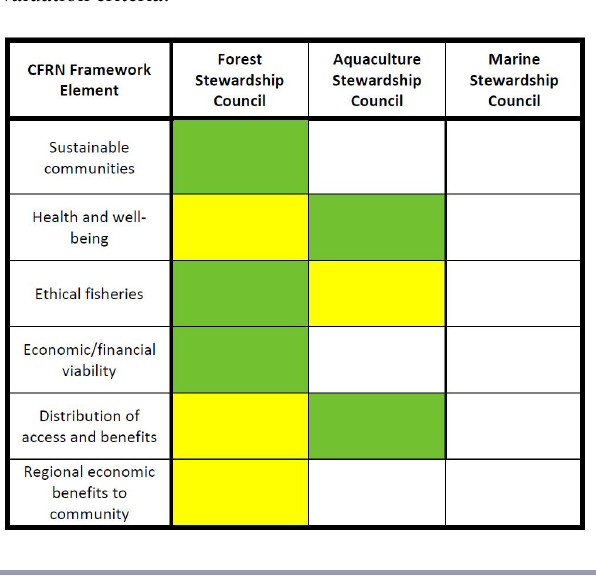
Fig. 3 . Certification criteria of three certification schemes categorized as complete (green), partial (yellow), or no (white) treatment of social and economic elements of the Canadian Fisheries Research Network (CFRN) sustainability framework evaluation